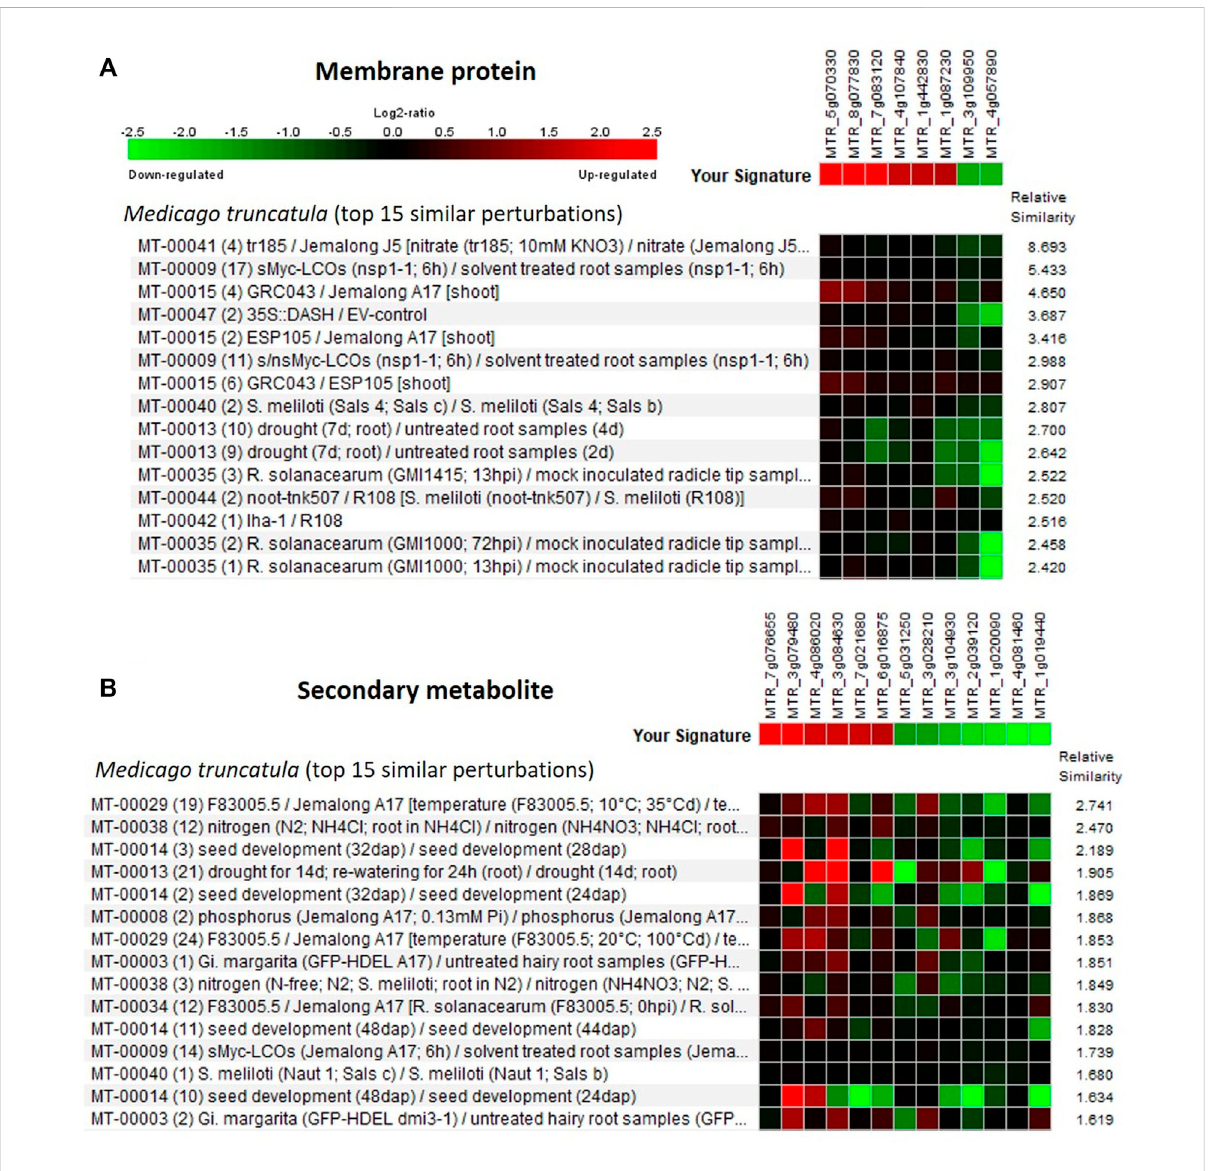
FIGURE 5 Heat map generated using the differentially expressed genes (DEGs) associated with (A) membrane protein and (B) secondary metabolite. Genevestigator ® was used, and the top 15 perturbations are